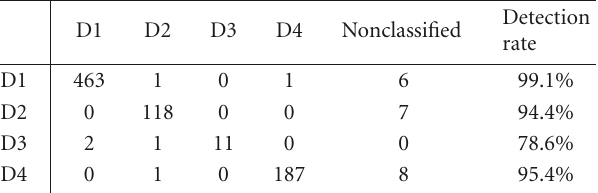
Table 5: Classification results for data from network B, where the SVM is trained with data from network